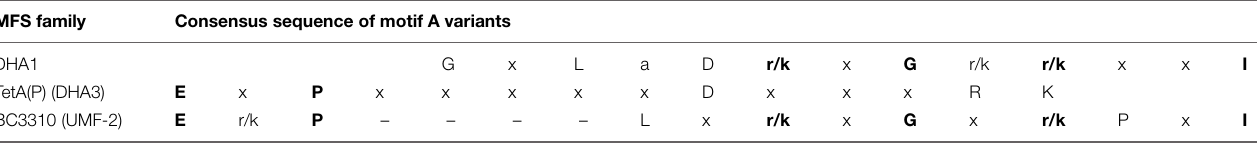
TABLE 4 | Consensus sequences of motif A variants found in MFS drug export families. MFS